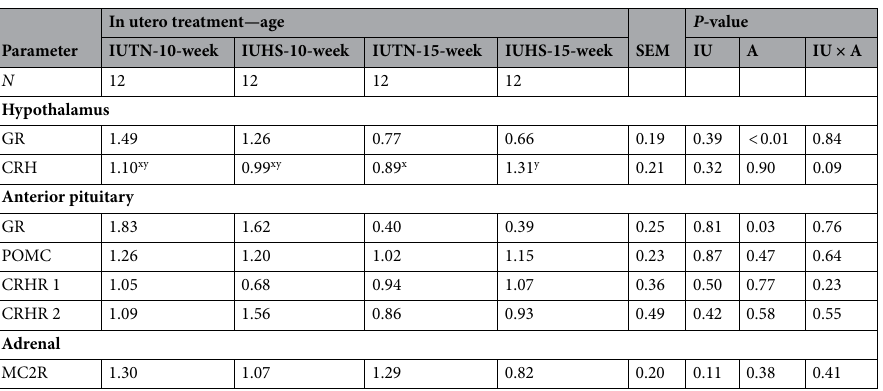
Table 3. Effects of in utero heat stress (IUHS) and age on the mRNA abundance of hypothalamic–pituitary– adrenal axis associated receptors and hormones in the hypothalamus, anterior pituitary, and adrenal glands of pigs. Letters ( x, y ) indicate tendencies (0.05 < P ≤ 0.10) within a row. IUTN in utero thermoneutral, IU in utero treatment, A age.